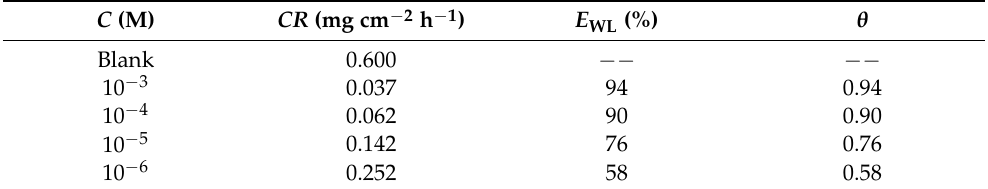
Table 1. Corrosion ratio and the % of protective effect on specimens following 6 h of exposure with and without